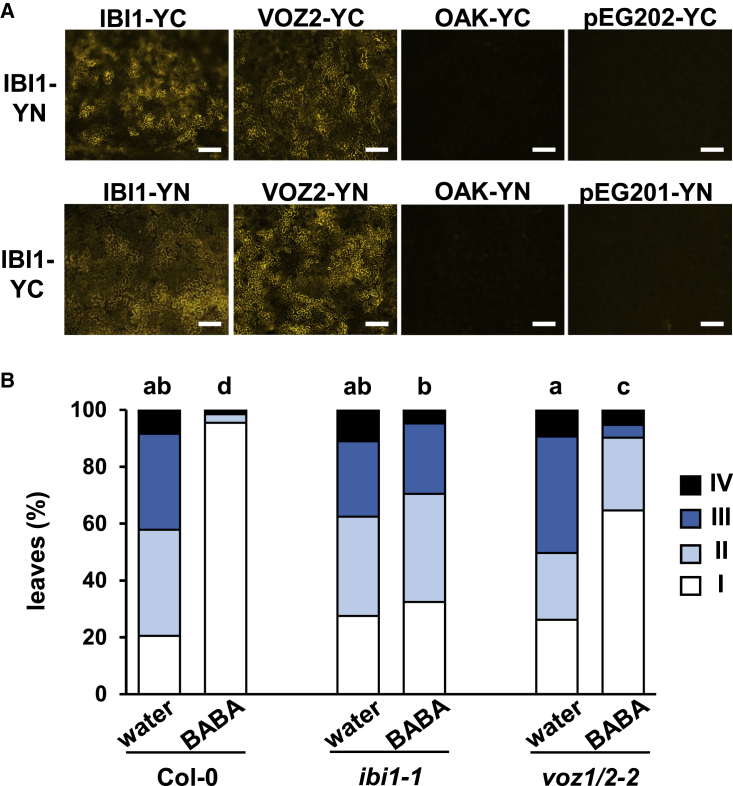
VOZ Proteins Interact with IBI1 In Planta and Are Required for BABA-IR.(A) The interaction between IBI1 and VOZ2 was tested by bimolecular fluorescence complementation (BiFC) analysis. Full-length gene constructs encoding proteins with a C-terminal fusion of the amino-terminal (-YN) or carboxyl-terminal (-YC) half of YFP were transiently expressed in N. benthamiana via leaf infiltration with A. tumefaciens. Specific interactions between protein constructs were determined by epifluorescence microscopy of YFP fluorescence at 3 days after infiltration. Co-infiltration with YN- and YC-tagged IBI1 proteins was used as a positive control to visualize the IBI1 autointeraction. Co-infiltrations of YN/YC-tagged IBI1 protein with the YC/YN-tagged membrane protein OAK or the empty vectors (pEarleygate201/202) were used as negative controls. Scale bars, 200 μm.(B) The voz1-2/voz2-2 double mutant (voz1/2-2) is partially compromised in BABA-IR against Hpa. Two-week-old Col-0, ibi1-1,and voz1/2-2 plants were soil-drenched with water or 5 mg/l BABA and inoculated with Hpa conidiospores 2 days later. Disease progression was determined at 5 dpi by assigning trypan blue-stained leaves to different Hpa colonization classes (Supplemental Figure 6). Different letters indicate statistically significant differences in class distribution between samples (Fisher's exact tests + FDR; p < 0.05; n = 60–150 leaves).